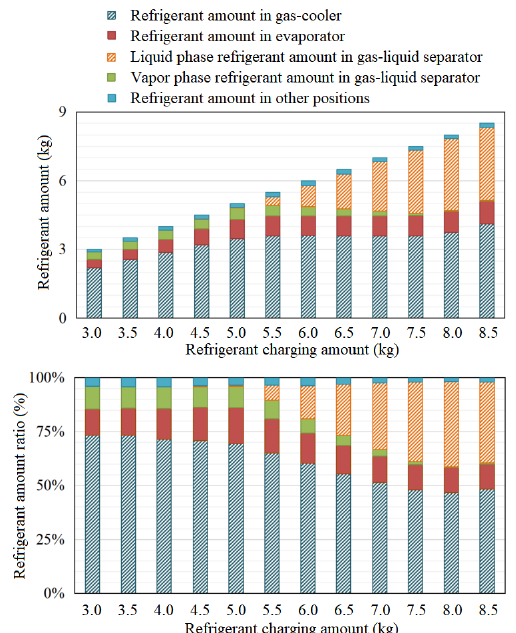
Figure 8. The refrigerant amount ratios in different positions under various refrigerant charging amounts.